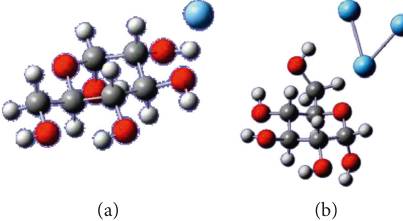
Figure 5: Optimized geometry of glucose with (a) a single silver atom and (b) the cluster of 3 silver atoms.